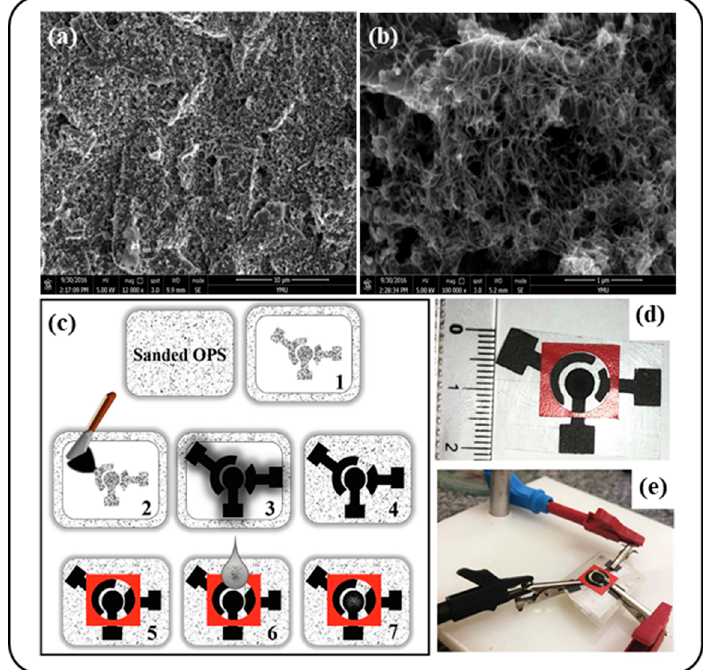
Figure 2. ( a ) The SEM characterization of the bare screen ‐ printed electrode (SPE) and ( b ) the multi ‐ walled carbon nanotubes modified screen ‐ printed electrode. Reprinted from Ref. [57] with permission from MDPI. Schematic representation of ( c ) SPE preparation, ( d ) images of the final device, and ( e ) the final SPE connected to the potentiostat. Reprinted with permission from Ref. [59] . Copyright (2020) Elsevier.